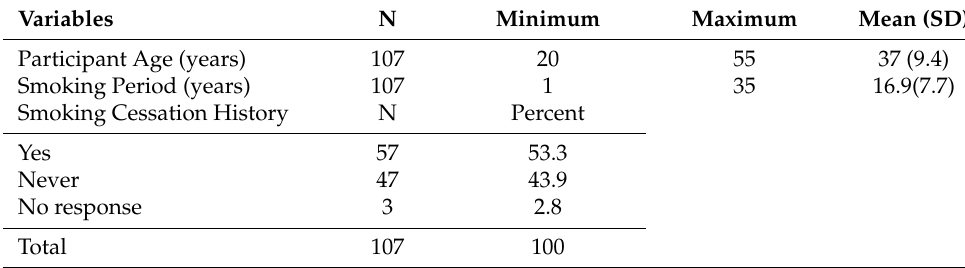
Table 1. The Study Participants’